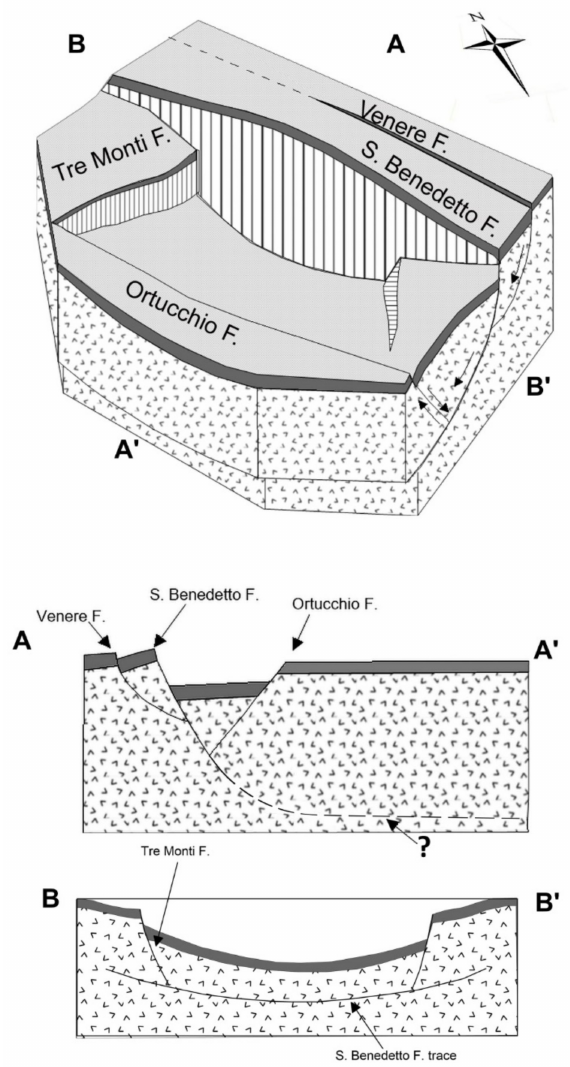
Figure 13. 3D conceptual sketch of the structural scheme of the Fucino half-graben (eastern side) as achieved from our study (figure not to scale). Modified from